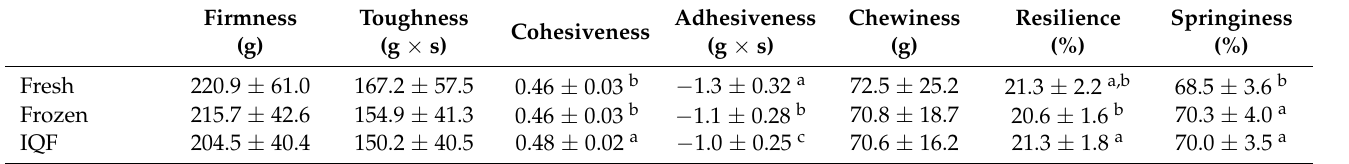
Table 4. Effects of cold-storage type on TPA attributes of catfish fillets. Values expressed as means ± standard deviations ( n = 30 for fresh, n = 40 for frozen, n = 49 for IQF).